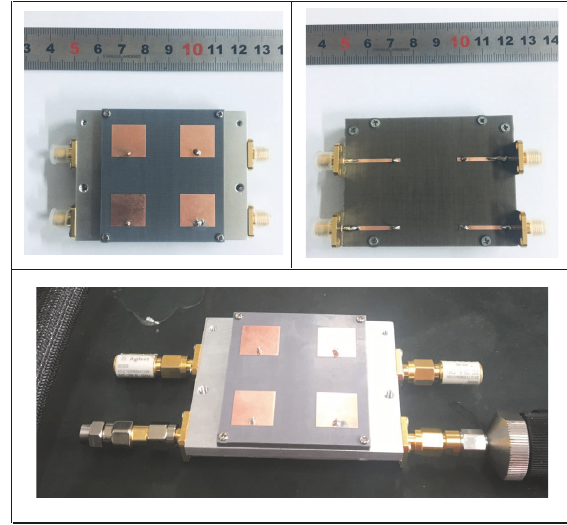
Figure 10: Antenna prototype and testing